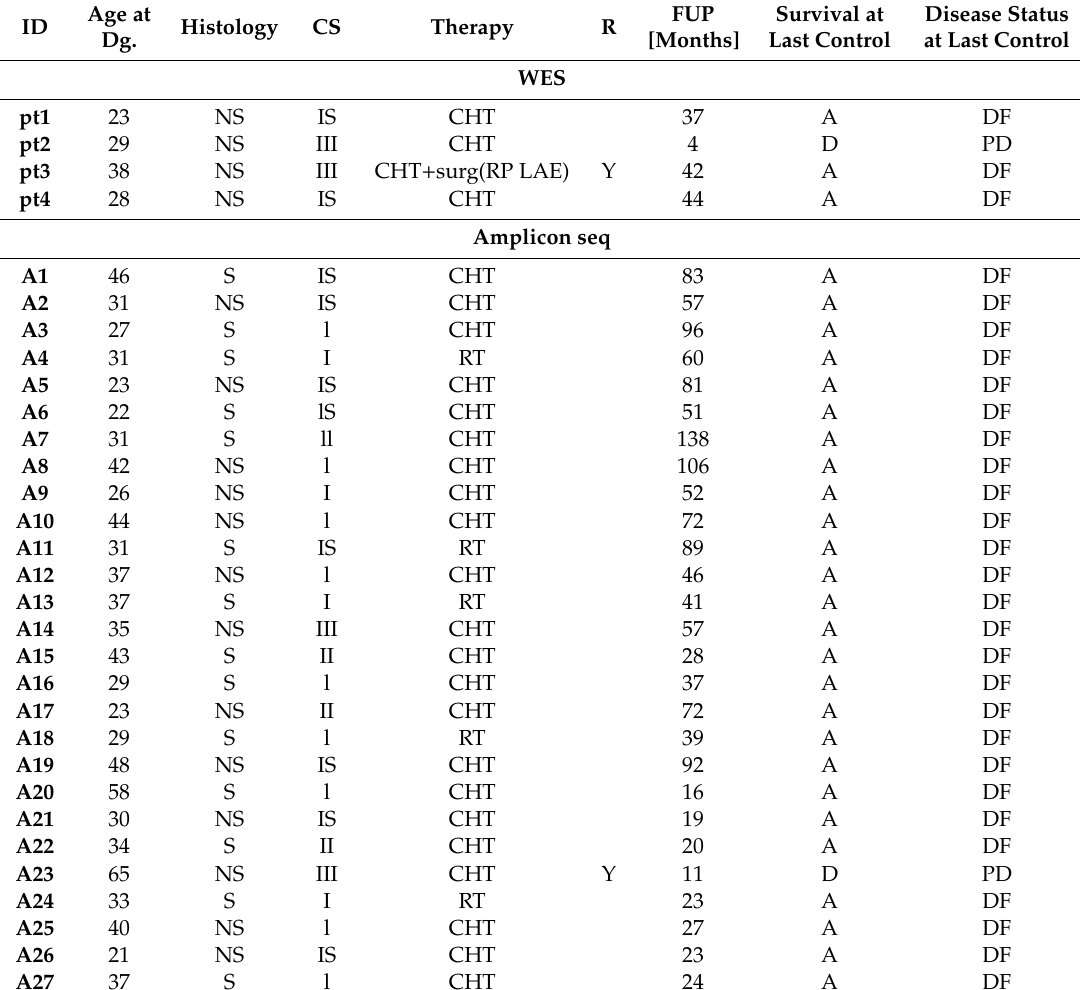
Table 5. Patients’